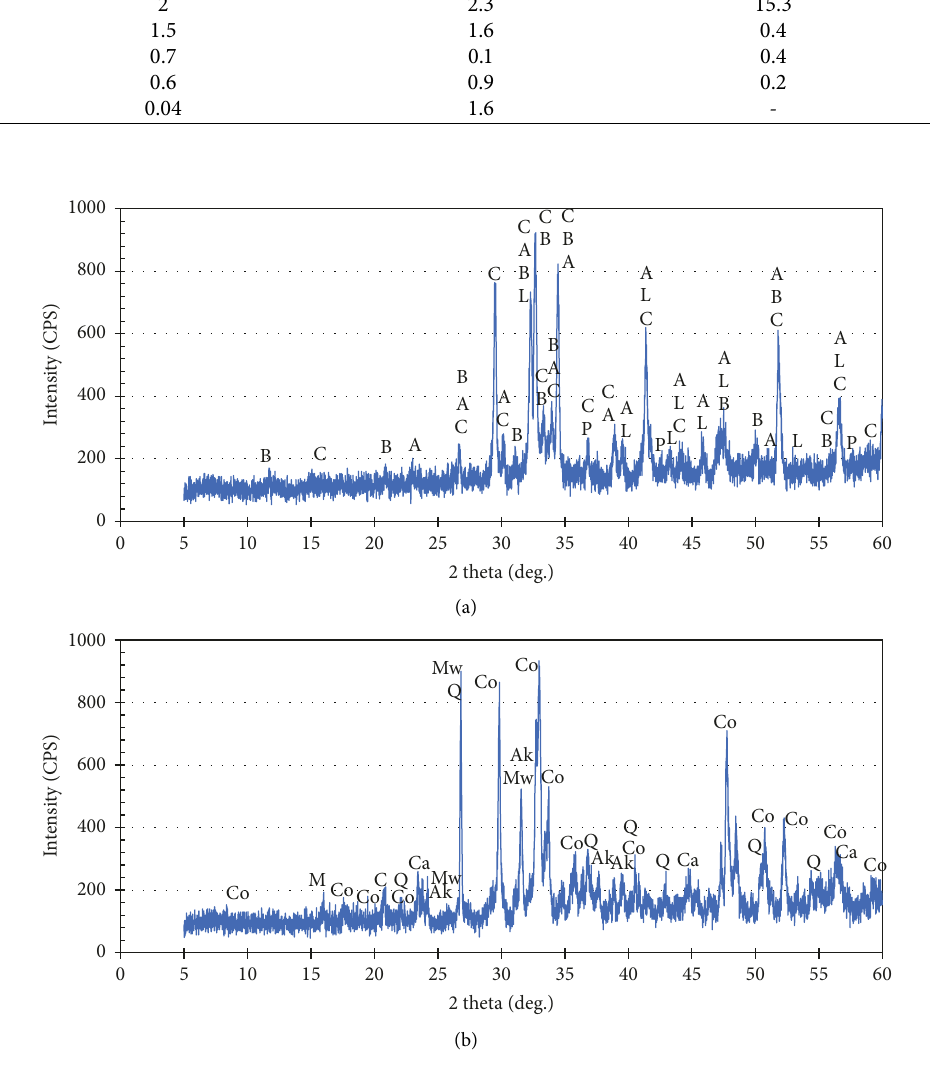
Figure 7: XRD patterns of (a) CEM-I and (b)